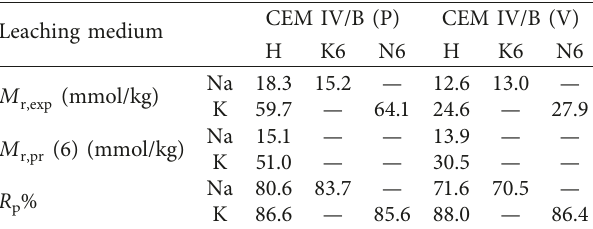
values for sodium and r